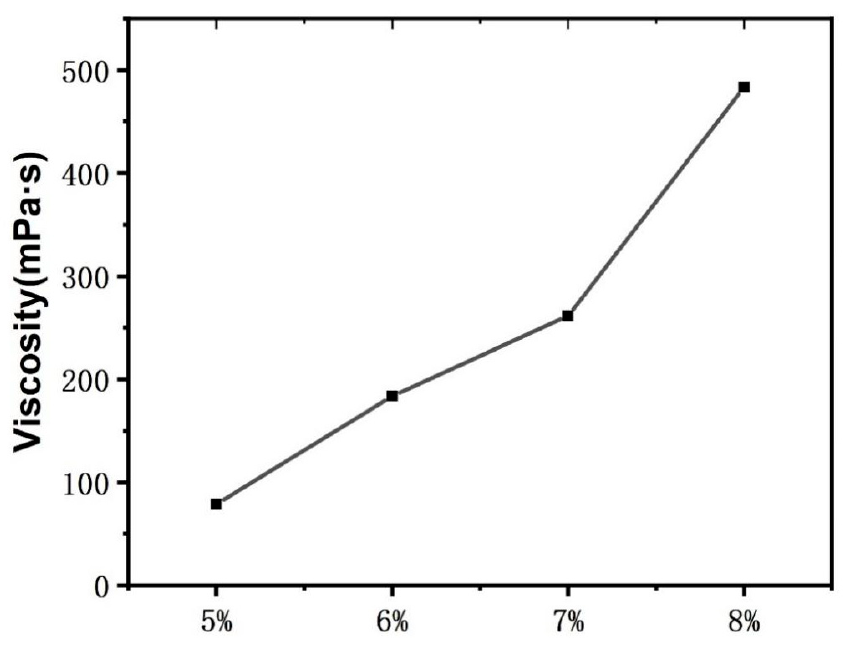
Figure 3. Diagram of the viscosity of the PLA spinning solutions with different concentrations.